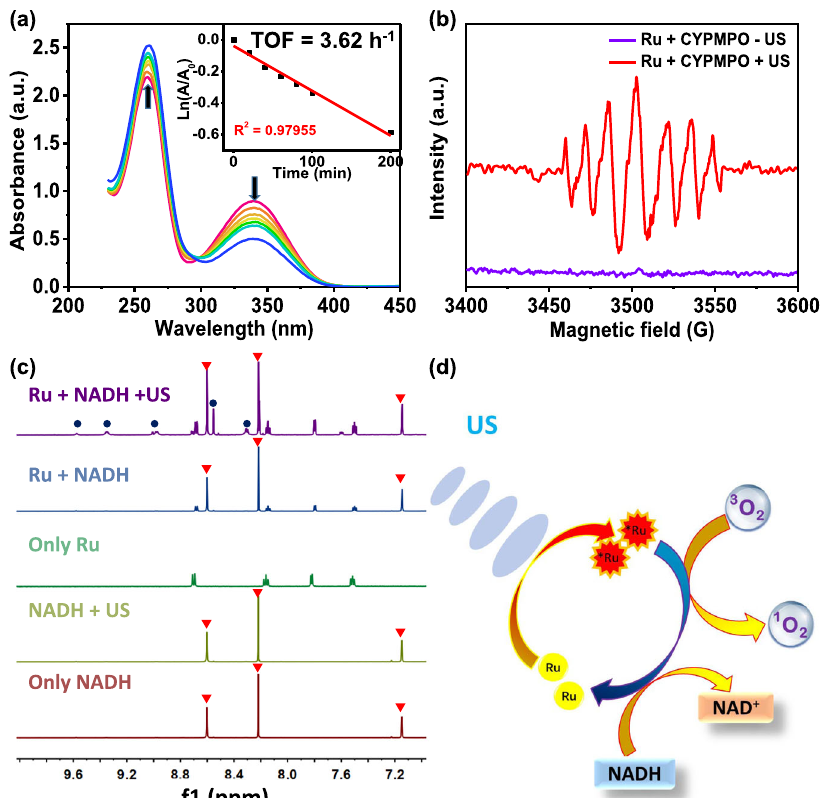
Fig. 2 Sonocatalytic oxidation of NADH by [Ru(bpy) 3 ] 2 + under US irradiation. a The oxidation of NADH (150 μ M) by [Ru(bpy) 3 ] 2 + (10 μ M) under US irradiation in PBS solution, as monitored by ultraviolet – visible spectroscopy. The direction of change in absorbance with time is indicated by the arrows. US irradiation time: 0, 20, 40, 60, 80, 100, 200 min. Insert: Plots of lnA/A 0 at 339 nm against time. b ESR spectrum of NAD • radicals trapped by CYPMPO demonstrating NADH oxidized by [Ru(bpy) 3 ] 2 + under US irradiation. CYPMPO (1 mg) was used for NAD • radicals in 50 μ L PBS solution containing [Ru(bpy) 3 ] 2 + (5 mM) and NADH (10 mM) under US (0.3 W cm − 2 , 3 MHz, 1 h) irradiation. c Sonocatalytic oxidation of NADH (1.1 mM) by [Ru(bpy) 3 ] 2 + (0.1 mM) in D 2 O/CD 3 OD (1:1, v/v) with US irradiation (0.3 W cm − 2 , 3 MHz, 20 min). Peaks labeled with red triangles represent NADH and peaks labeled with blue circles represent NAD + . d The proposed mechanism of 1 O 2 generation and NADH sonocatalytic oxidation by [Ru(bpy) 3 ] 2 + under US irradiation. Ru: [Ru(bpy) 3 ] 2 + ; TOF: turnover frequency; CYPMPO: 5-(2,2-dimethyl-1,3-propoxycyclo-phosphoryl) − 5-methyl-1-pyrroline-N- oxide; NADH: 1,4-dihydronicotinamide adenine